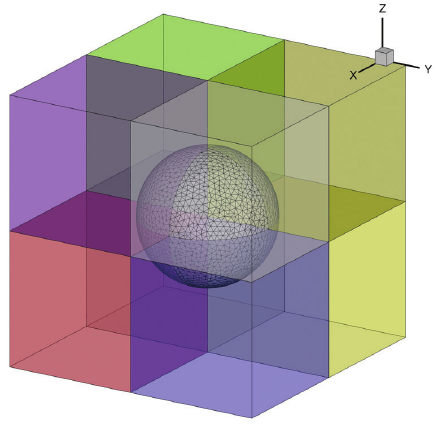
Figure 6 - Immersed geometry in the computational domain. Parallel computing is used. Each one of the Cartesian block is a subdomain assigned to a different CPU or processor core.